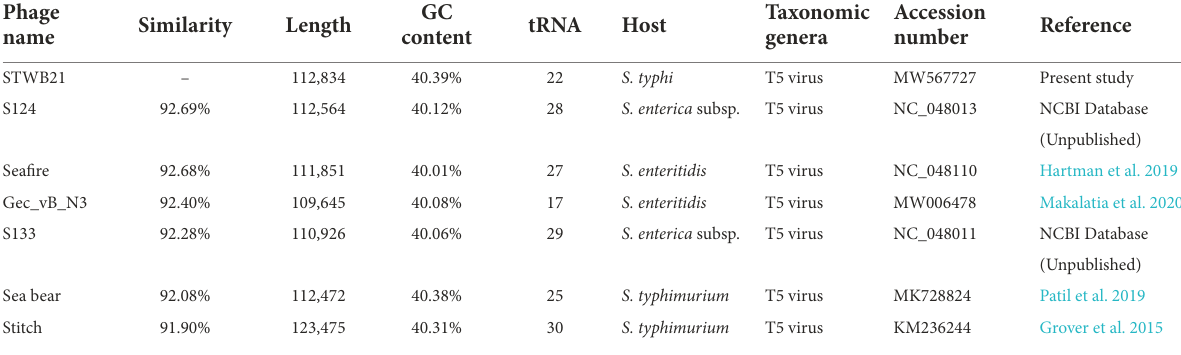
TABLE 3 List of reported Salmonella phages from Siphoviridae family.